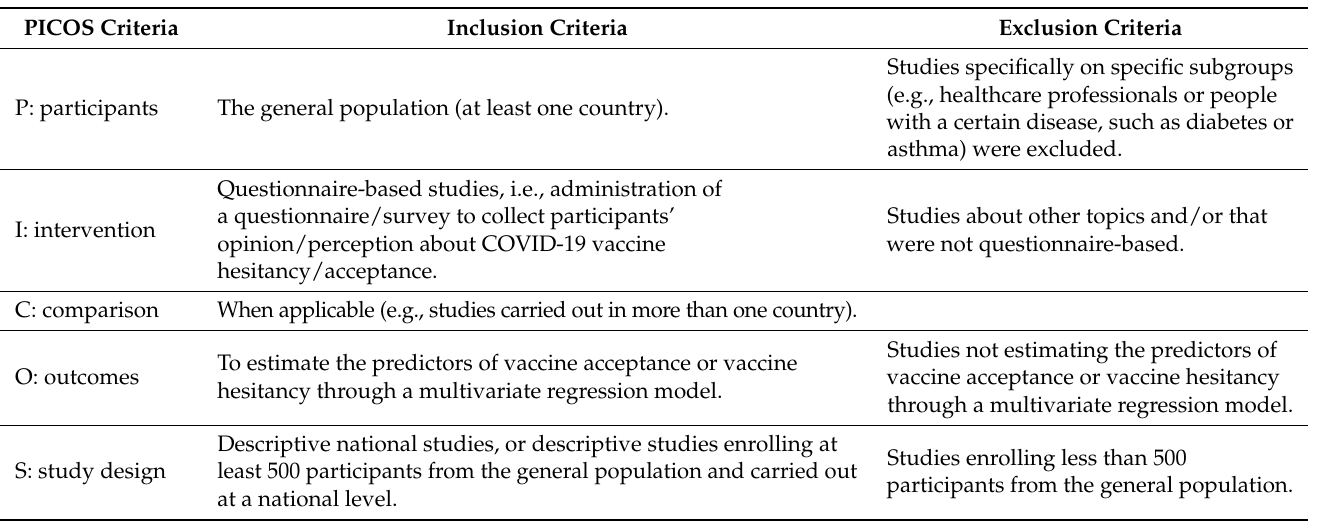
Table 1. PICOS: inclusion and exclusion criteria.